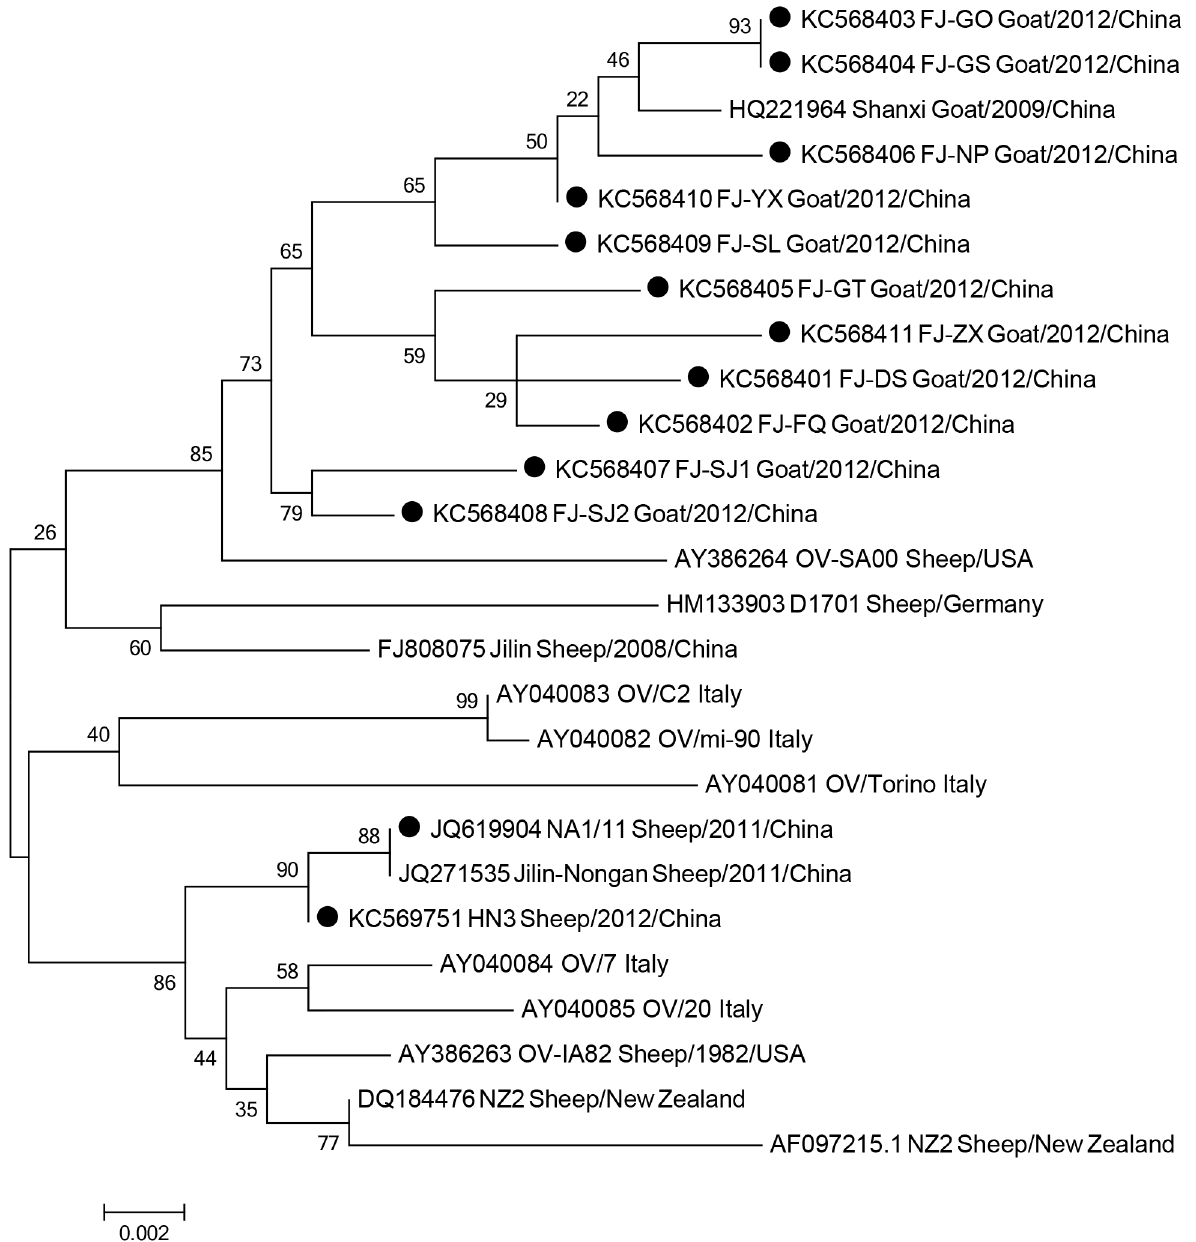
Figure 7. Phylogenetic analysis based on nucleotide sequences of ORFV059. The phylogenetic relationship was constructed by Maximum Likelihood Method using MEGA 5.0 software. Black circles: 11 different orf isolates from Fujian Province (China) and two orf isolates from other provinces.